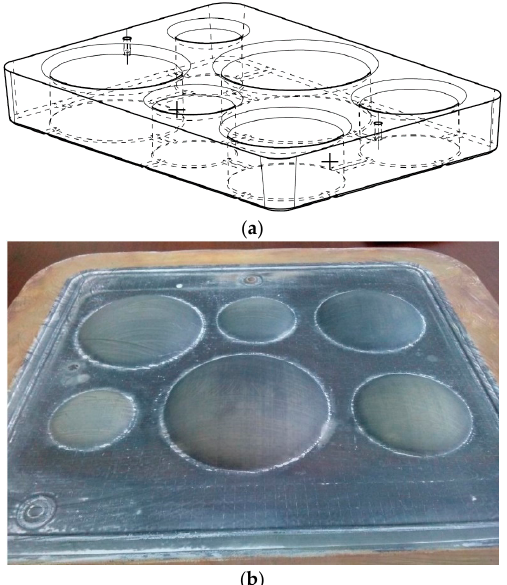
Figure 2. Multi-dome mold ( a ) and the specimen after the test ( b ).